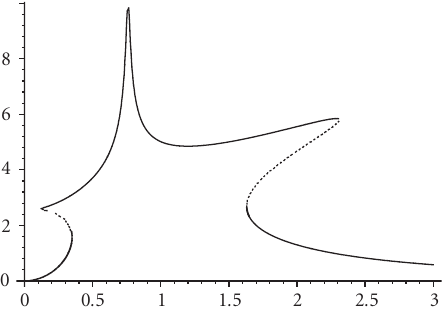
Figure 3.1. Dependence of the amplitude A on the frequency ω . Solid lines denote stable branches while dotted lines mark unstable